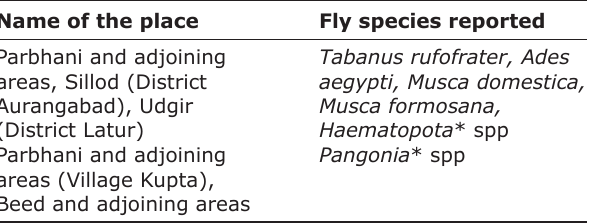
Table-2: Fly species reported from Parbhani and other parts of Marathwada